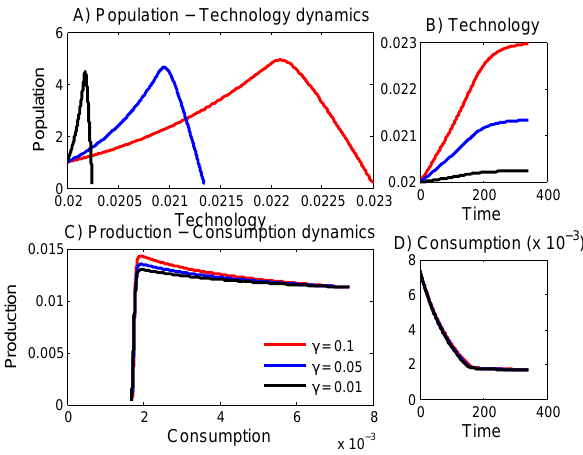
Figure 8. (a) The asymptotic technological level is super- exponential in the rate of success. (b) The escape of society from the physical limit beyond the critical rate of success γ c , when tech- nological singularity appears. Note that for γ <γ c , the population decline appears before the physical limit of water resource avail- ability is reached, while for γ ≥ γ c , population explodes to infinity (hence its peak) at the same time when technological singularity